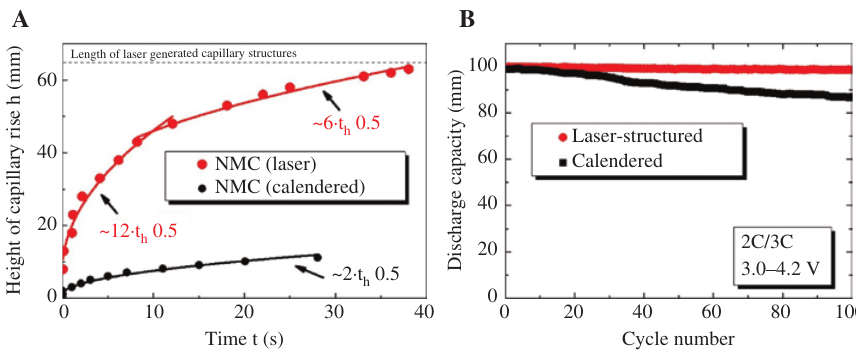
Figure 25: Comparison between laser structuring and structuring via embossing/calendering: (A) height of capillary rise as a function of time for structured NMC, and (B) discharge capacity as a function of cycle number for cells with laser-structured and embossed